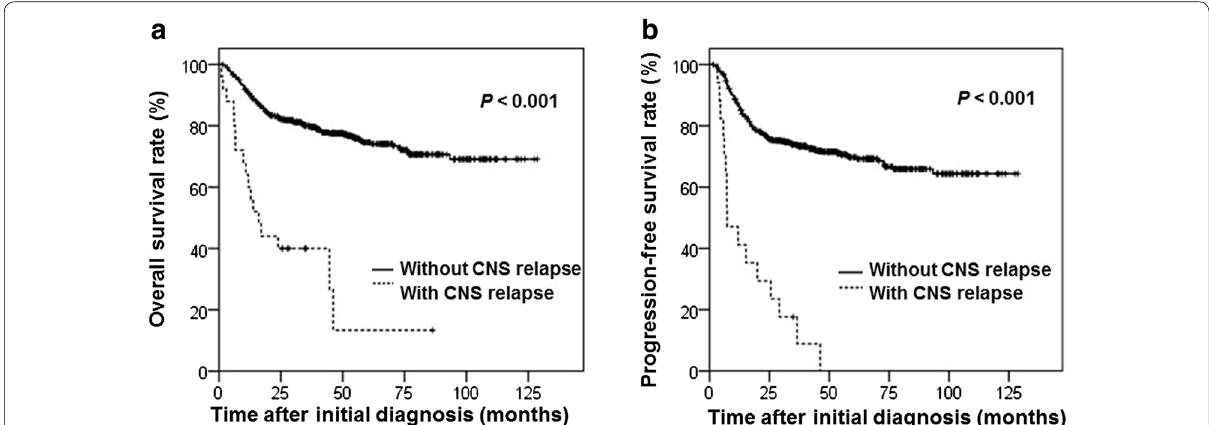
Fig. 4 Kaplan–Meier analysis estimated overall survival (OS) and progression‑free survival (PFS) for 511 DLBCL patients with or without CNS relapse. CNS relapse was associated with short OS ( a ) and short PFS ( b